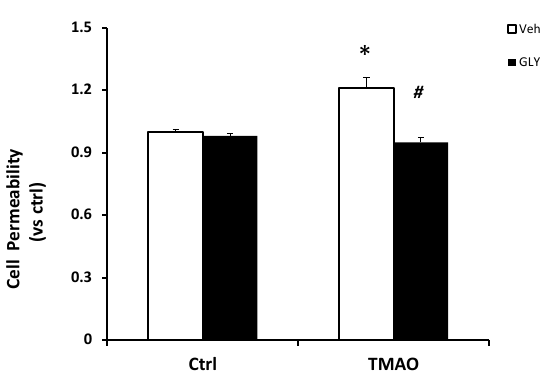
Figure 5. Inhibition of HMGB1 abolishes TMAO-induced cell permeability in EOMAs. Values are arithmetic means ± SEM ( n = 6 each group) of cell permeability in EOMAs with or without stimulation of TMAO and / or glycyrrhizin. * significant di ff erence ( p < 0.05) compared with the values from control cells, # significant di ff erence ( p < 0.05) compared with the values from the TMAO-treated group.